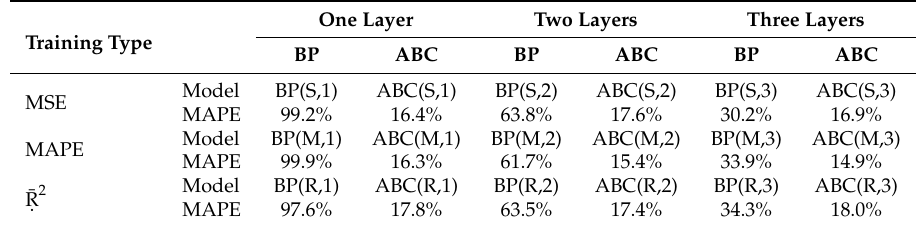
Table 5. Day-ahead forecasting